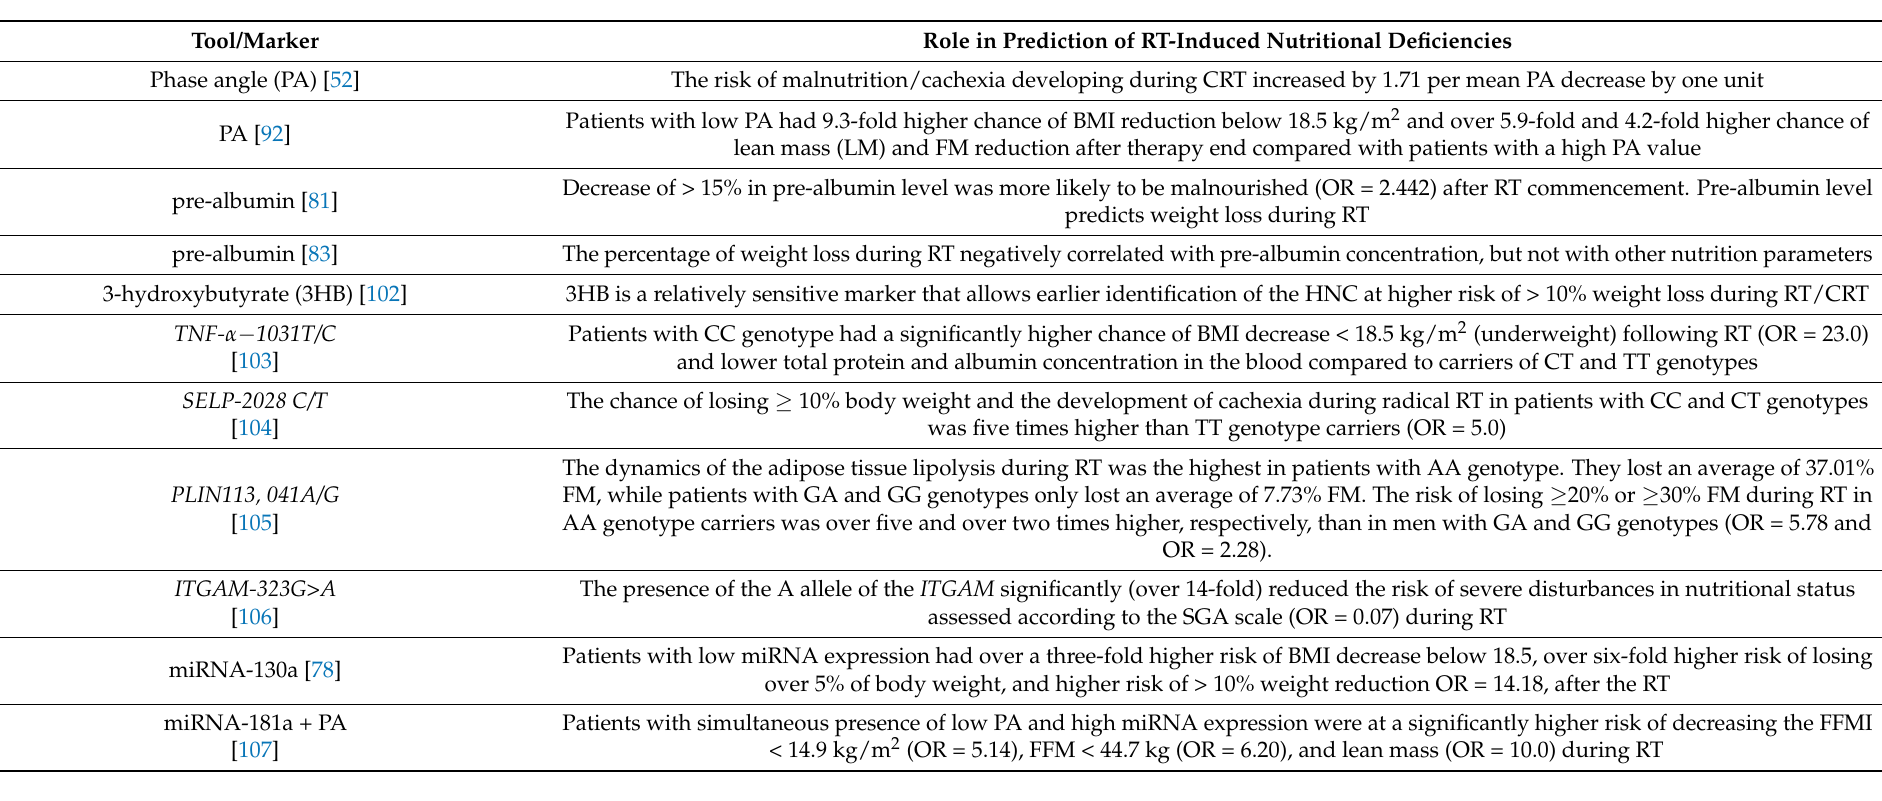
Table 3. Tools/markers used in prediction of RT-induced malnutrition, cachexia, and body composition changes in HNC patients (anthropometric measurements and clinical scales were